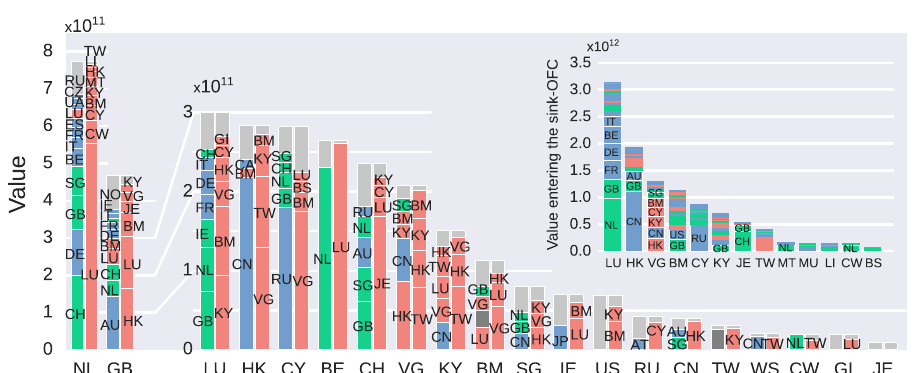
Figure 4. Geographical specialization. The value going through each conduit in chains of size three ending in sink-OFCs is depicted. The first column visualizes the source countries, the second column represents the sink countries, and the horizontal axis shows the conduit countries. Sink-OFCs are marked red and conduit- OFCs are marked green, all countries representing less than US$10 10 are combined together in gray. Dark gray corresponds to companies with unknown location. (inset) Value invested from companies located in sink-OFCs (horizontal axis) into other